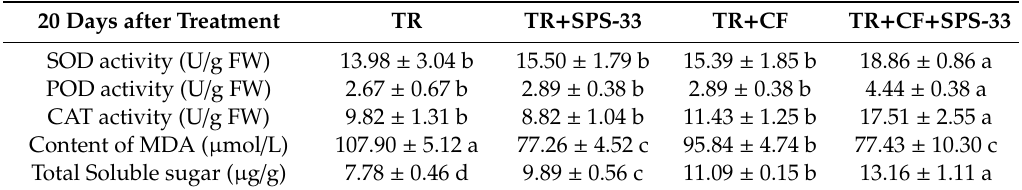
Table 1. E ff ect of SPS-33 fumigation on enzyme activities, MDA content, and total soluble sugar content in sweet potato